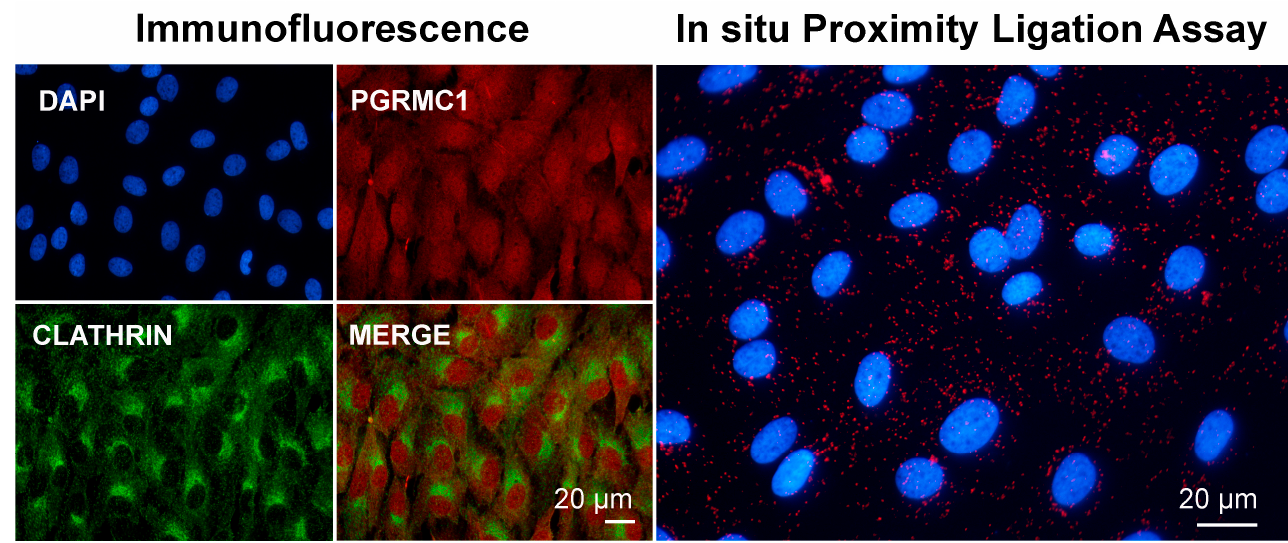
Figure 3. Images showing immunofluorescent and in situ proximity ligation assay to assess the association of PGRMC1 and clathrin in in vitro cultured bovine granulosa cells. Analysis was conducted as described in [113,163] with proper combination of antibodies, which were rabbit anti- PGRMC1 (Sigma Aldric Prestige antibody HPA002877, 1:50) and mouse monoclonal anti-clathrin heavy-chain antibody (X22) (ThermoFisher Scientific, 1:500). Nuclei were counterstained with DAPI. Data were presented at the 48th Annual Meeting of the Society for the Study of Reproduction, 18–22 June 2015, San Juan, Puerto Rico, USA.